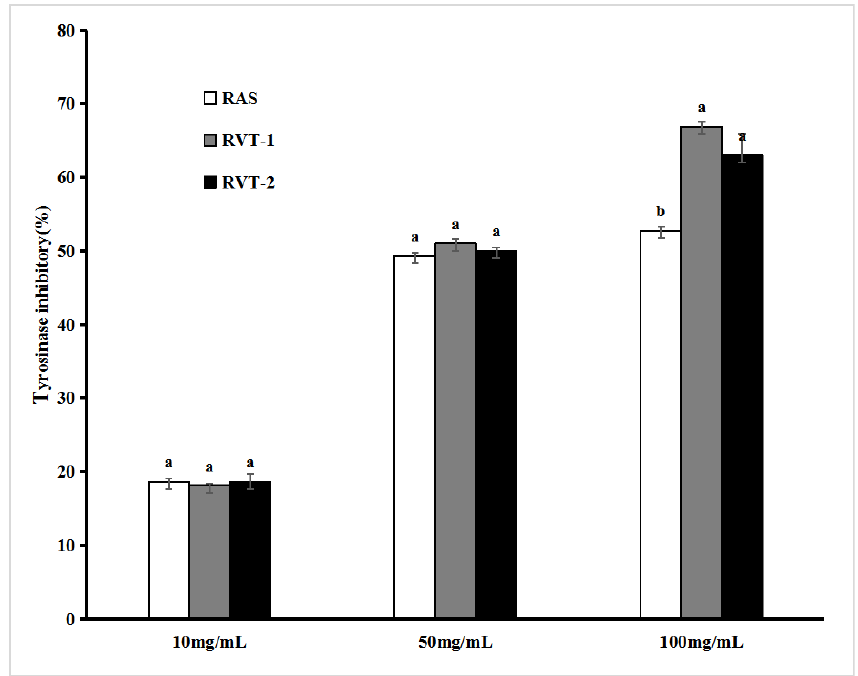
Figure 3. Tyrosinase inhibitory ability assays for RVT and RAS. Values with different letters within the same substance are significantly different ( p < 0.05). All data were expressed as the means ± SD, n = 3.